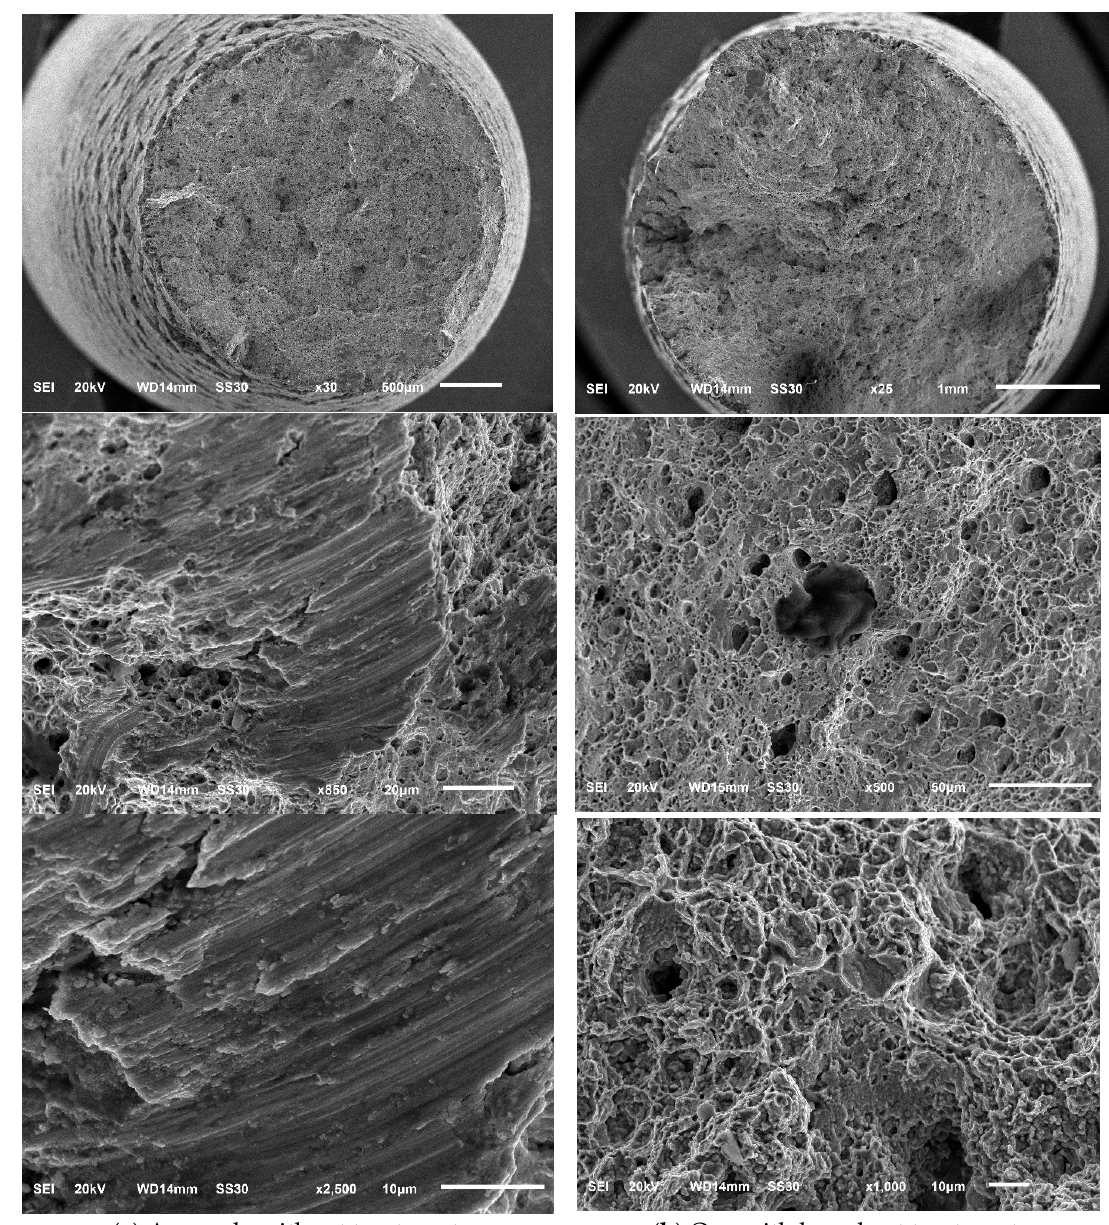
Figure 3. Microstructure diagram of alloy sample.